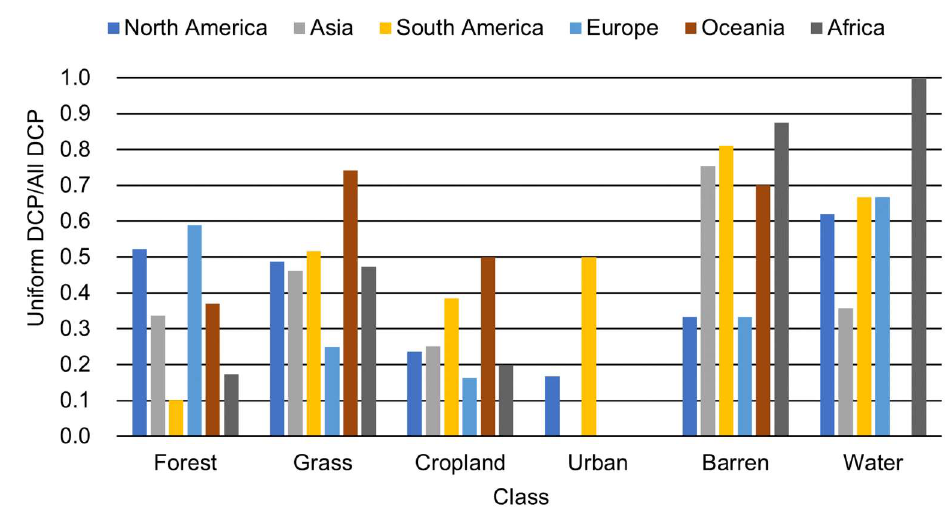
Figure 7. Proportion of DCP points with guaranteed spatial uniformity among all DCP points per continent in the 990 m scale.